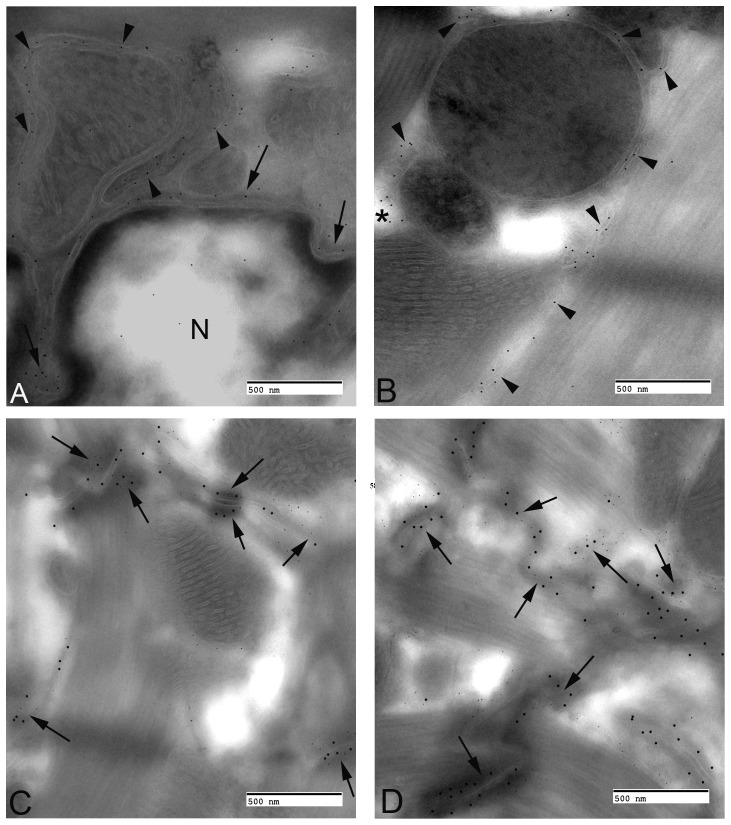
TMEM43 distribution and association with ZO-1 and JUP in the intercalated disc of normal murine myocardium.
A. Electron micrograph of a double immunogold labeled section of the perinuclear region of a cardiac myocyte that has been labeled with TMEM43. Particles were located diffusely throughout the nucleus (N), on the nuclear membrane (arrows) and on components of the sarcotubular network (arrowheads). B. Sarcoplasm of a cardiac myocyte. Note the labeling on the sarcoplasmic reticulum (arrowheads) on vesicular components of the sarcotubular network (asterisk). Figure 4C represents co-localization of TMEM43 (10 nm gold particles) with ZO-1 (15 nm gold particles). Arrows indicate two adherens junctions that contain both ZO-1 and TMEM43. Figure 4D represents co-localization of TMEM43 (10 nm gold particles) with JUP (15 nm gold particles) in desmosomes and adherens junctions (arrows) of the intercalated disc. All bars equal 0.5 µm.